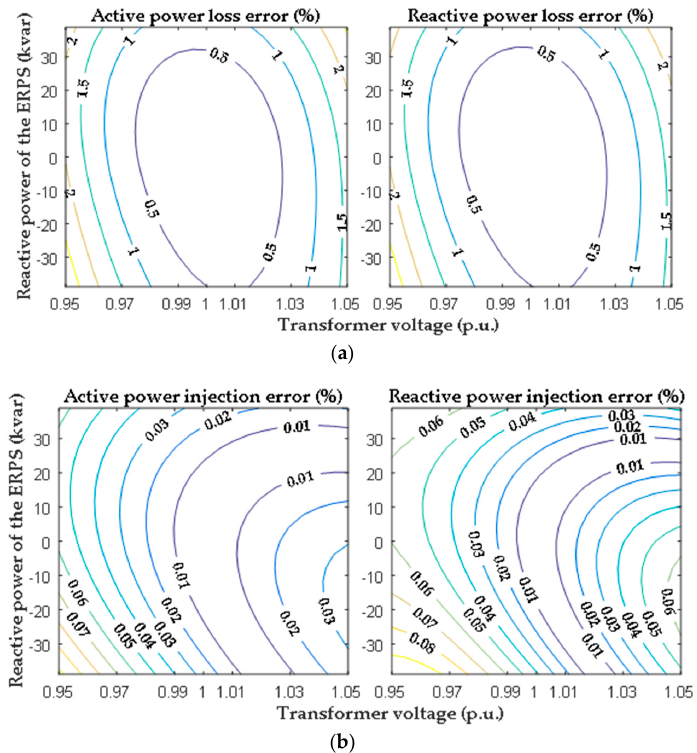
Figure A1. Error in the network power loss and residual power injection for low-voltage system 2. ( a ) Network power loss; and ( b ) residual power injection.